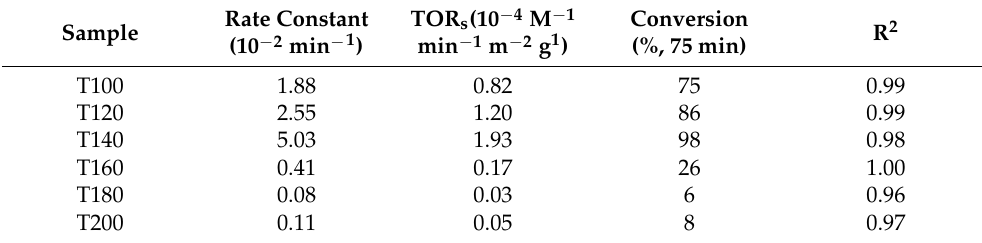
Table 2. Rate constants for the degradation of MB using TiO 2 NPs obtained at different temperatures.